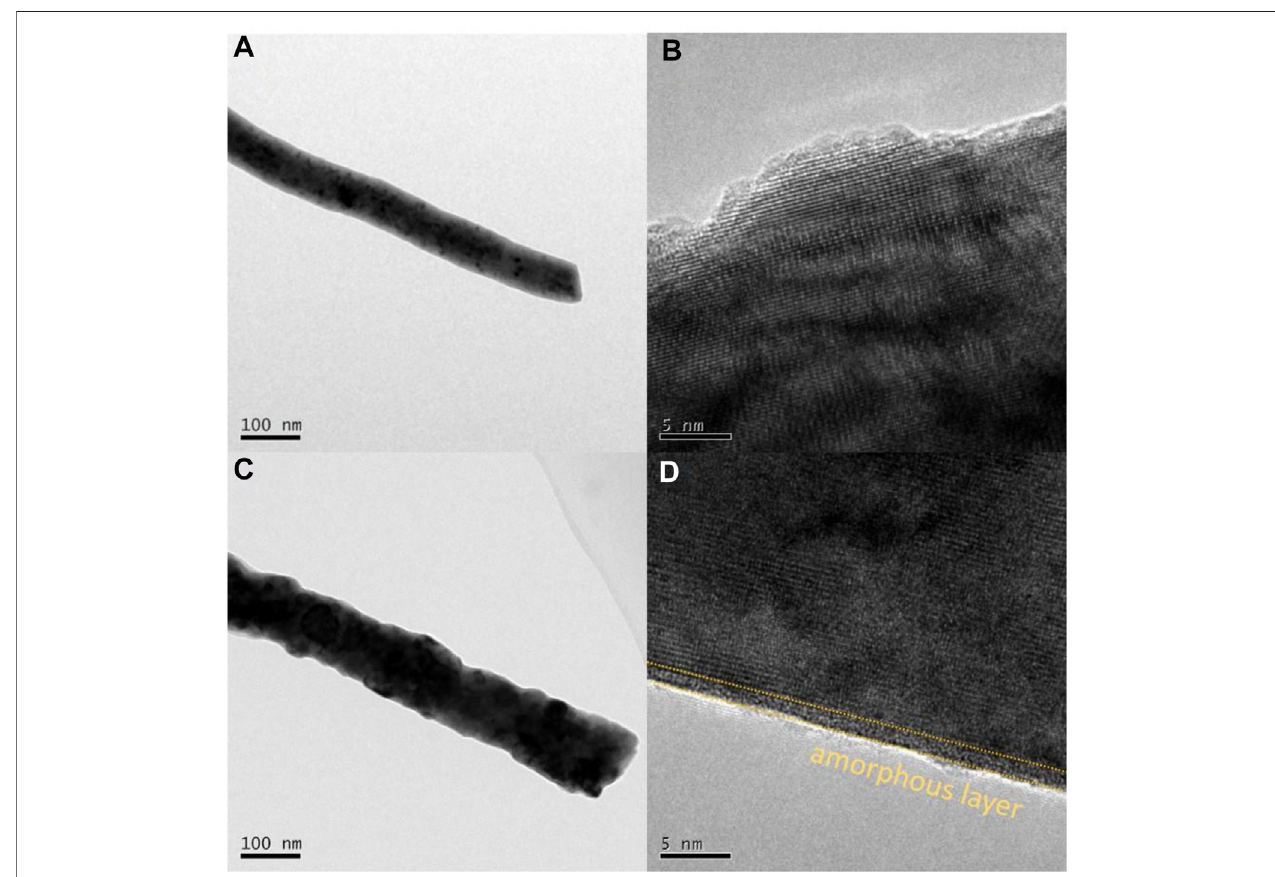
FIGURE 5 | TEM images of (A, B) PrBaCo 0.8 W 0.2 , (C, D) PrBaCo 0.8 W 0.2 after stability test.